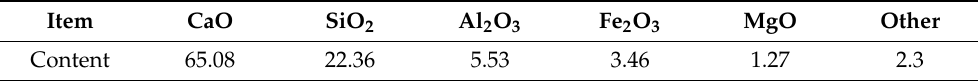
Table 3. Chemical composition content of P.O42.5 cement (unit: